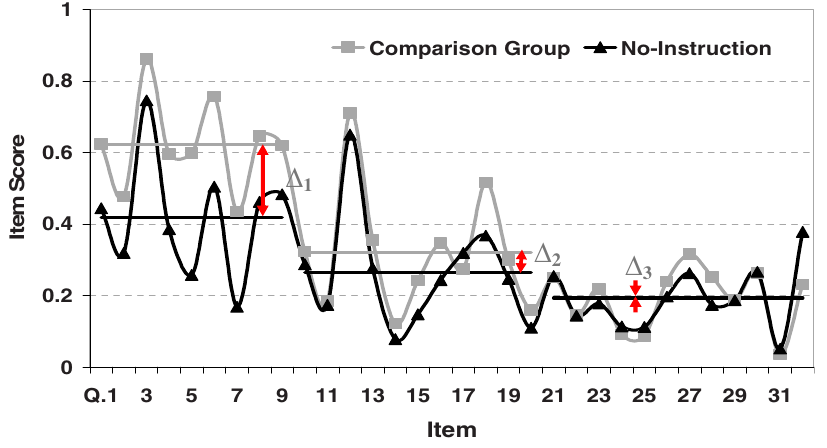
FIG. 3. (cid:1) Color (cid:2) Pre-test item scores of the comparison group and the no-instruction group. The curves show the trend of item scores; the straight lines connect the average item scores in each